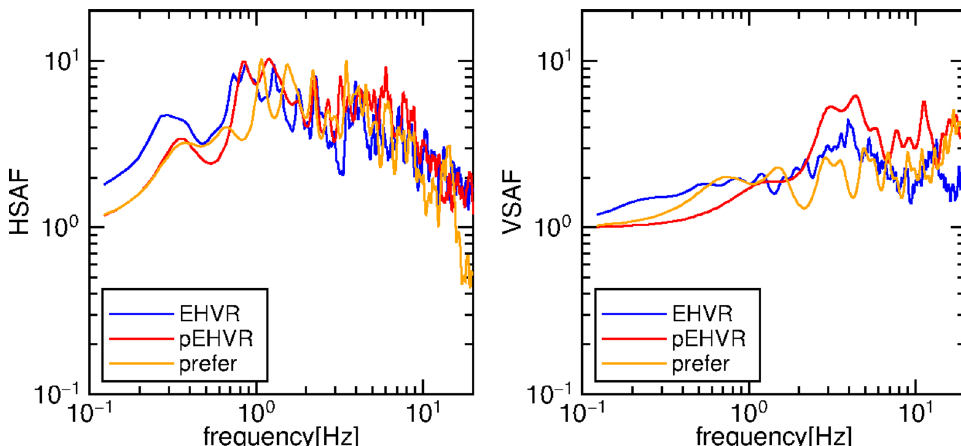
Fig. 6 Comparison of the theoretical HSAFs and VSAFs from the velocity models inverted for the converted pEHVR (red) and the observed EHVR in Step-2 (blue), together with those from the preferred model distributed by the CBP-ESG6